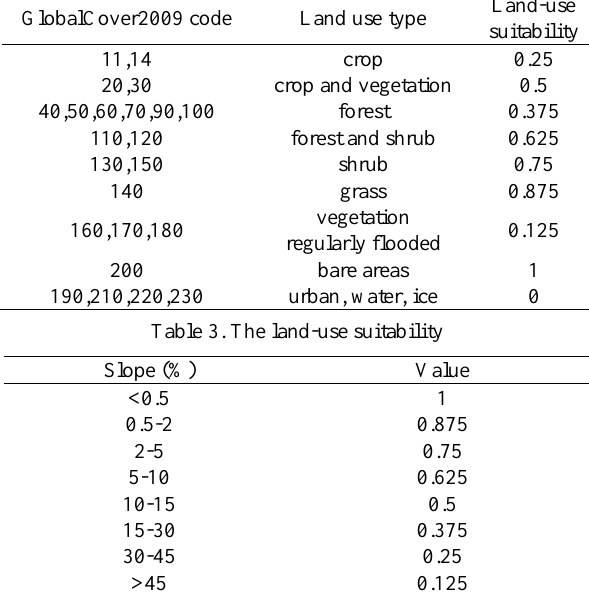
Table 4. The slope